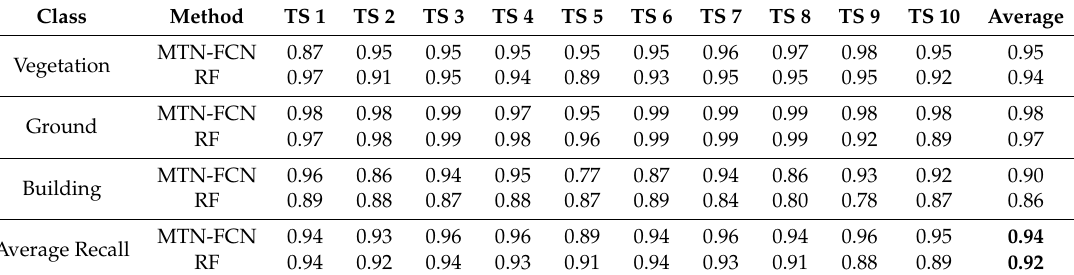
Table 9. Recall values of the AHN3 dataset. MTN: Multi-Task Network, RF: Random